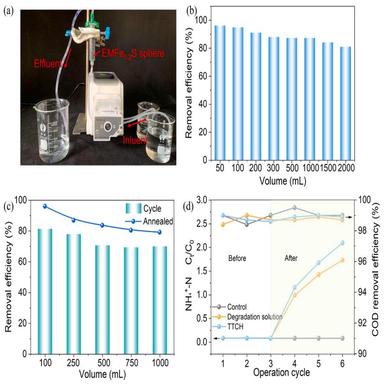
(a) Schematic diagram of a continuous flow catalysis experiment; (b) removal efficiency of 2000 mL of TTCH in continuous flow catalytic experiment; (c) reproducible use of EMFe0.2S in continuous flow catalysis experiments; (d) variation of NH4 +-N and COD removal efficiency with operation cycle.